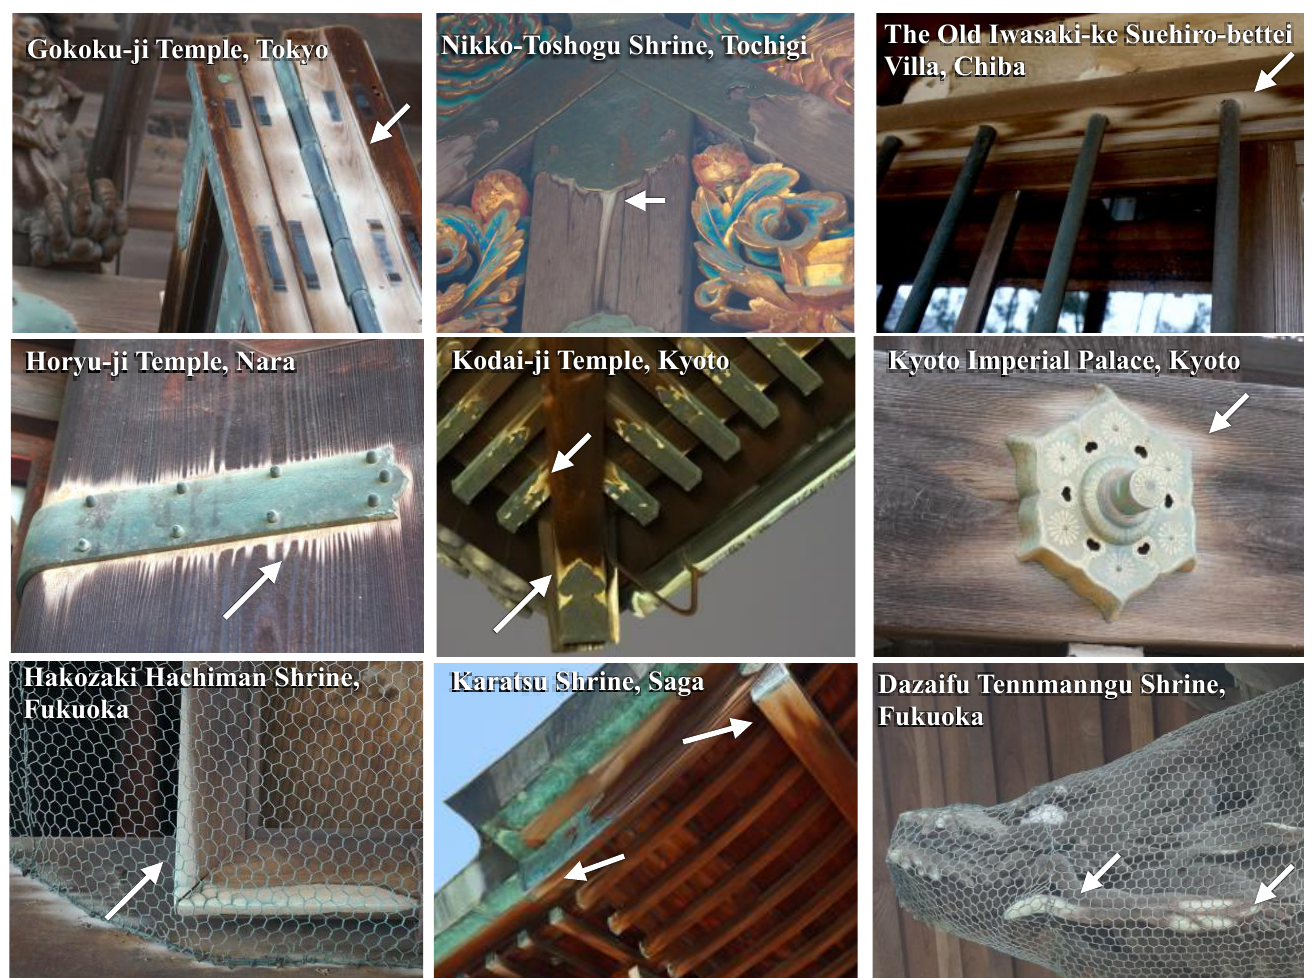
Figure 1. The whitening phenomenon of wood adjacent to metal components (white arrows pointing to the area) can be seen in the case of Japanese historic architectures. Reproduced with permission from ref [2]. 2021 Taylor & Francis.